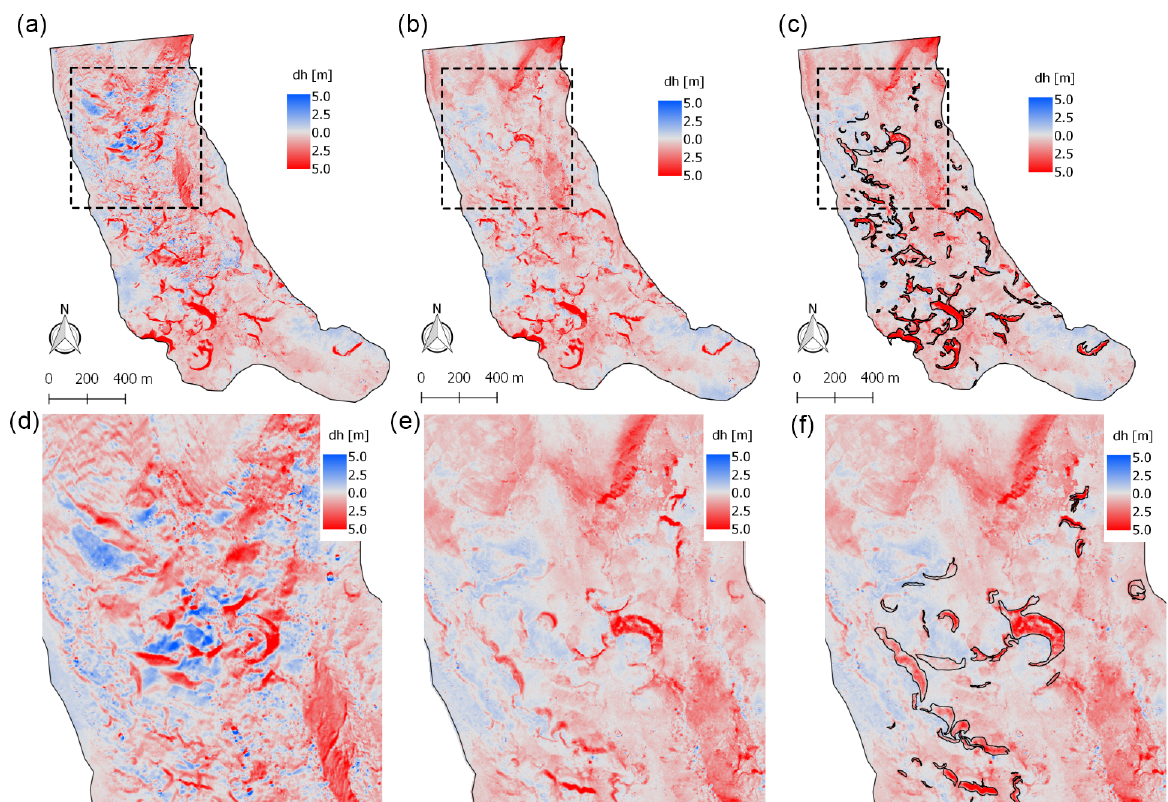
Figure 4. Panels showing maps of elevation change from UAV (a, d) before flow correction and (b, c, e, f) after flow correction over the period 23 November 2015–16 November 2016. Black outlines on panels (c) and (f) are the cliff footprints. Panels (d) , (e) and (f) are close-ups of the panels (a) , (b) and (c)